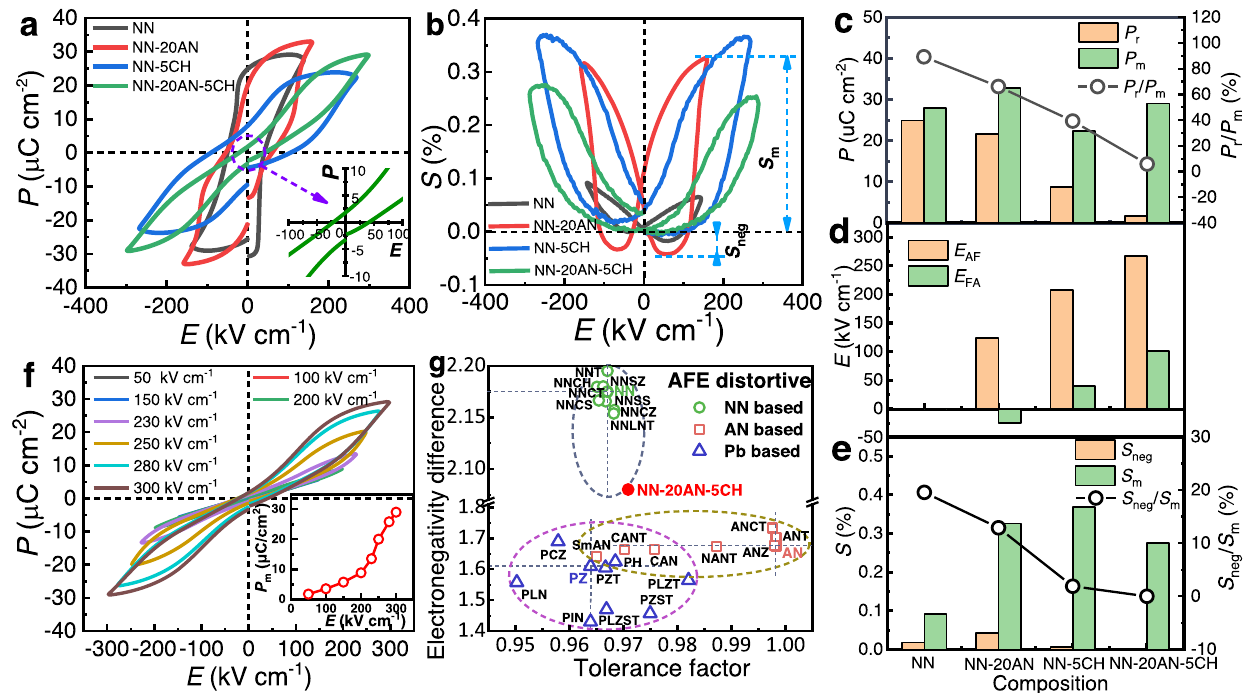
Fig. 4 | The polarization and strain of the newly designed NN-based ceramics. a P – E loops and ( b ) S – E curves. The inset of a shows magni fi ed scale for NN-20AN- 5CH.Compositionsdependenceof( c ) P m , P r , P r / P m ;( d ) E AF , E FA ;( e ) S m , S neg , S neg / S m , derivedfromthe P – E loops,the I – E